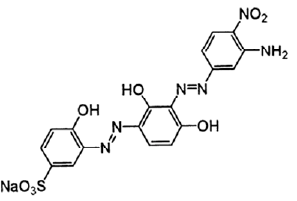
Figure 1. Chemical structure of Acid Brown 83.